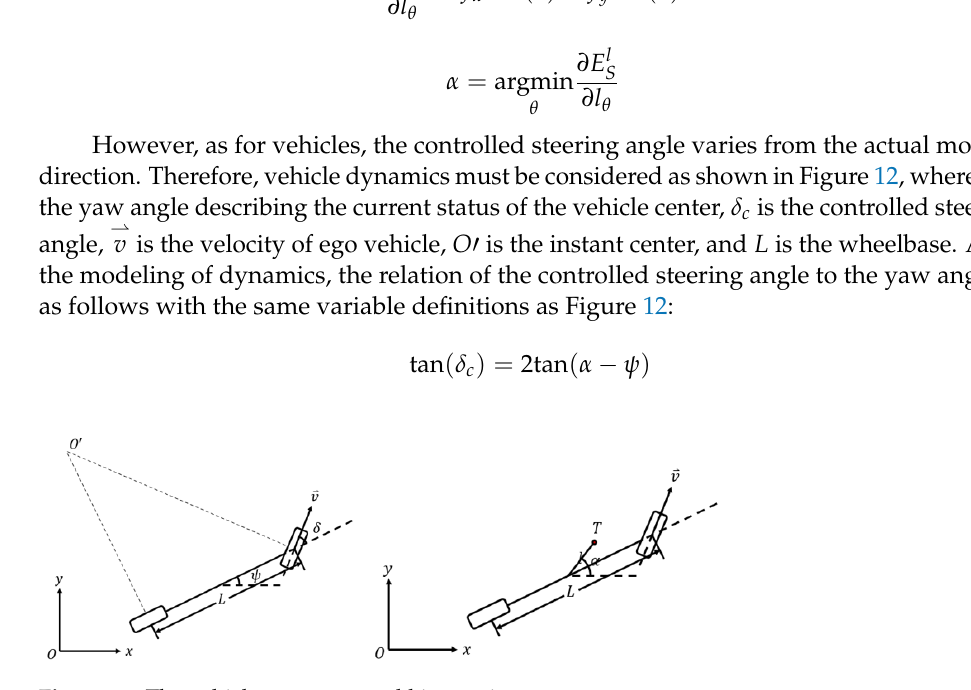
Figure 11. Analysis of variable target thought.